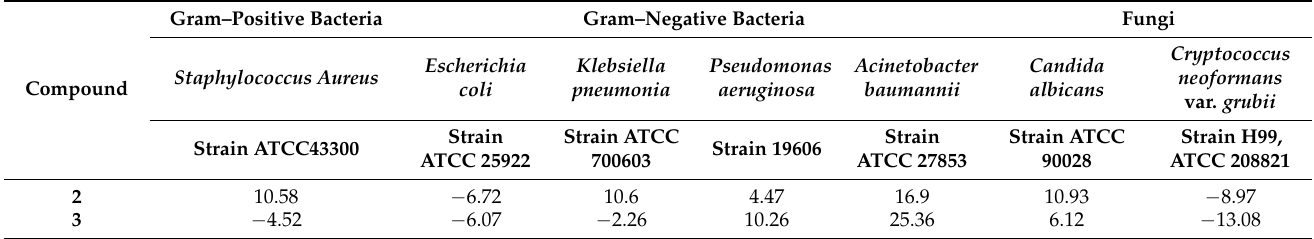
Table 3. % Growth inhibition of compound 2 and 3 at 32 µ